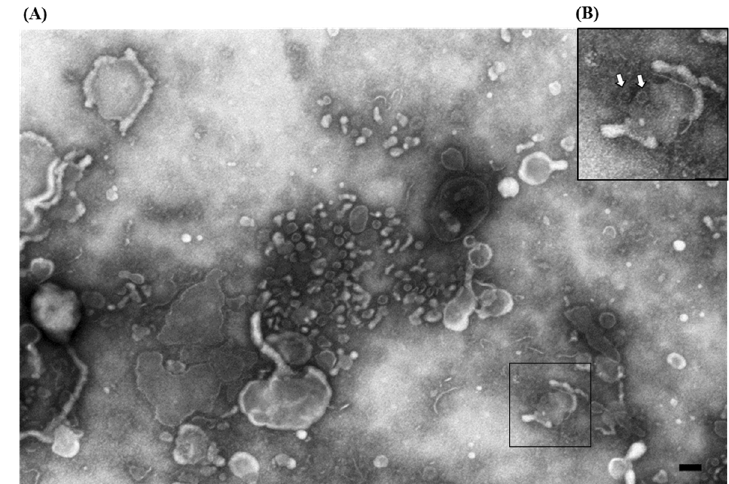
Figure 7. Electron micrograph of ultracentrifuged trachea and lung extract from rabbits infected with an organ homogenate of Rabbit Hemorrhagic Disease (RHD) from naturally infected rabbits. ( A ) A few rare calicivirus particles (see rectangle) are in the dirty and rich material, and thus, are hardly visible; ( B ) enlargement of inset, showing the typical morphology of calicivirus particles (  ). The presence of RHDV particles in these pictures was done ex post. Thus, only after the definitive characterization of RHDV as a calicivirus were they recognized. Negative staining (2% sodium phosphotungstate). TEM Siemens Elmiskop 102, 80 kV. Bar = 100